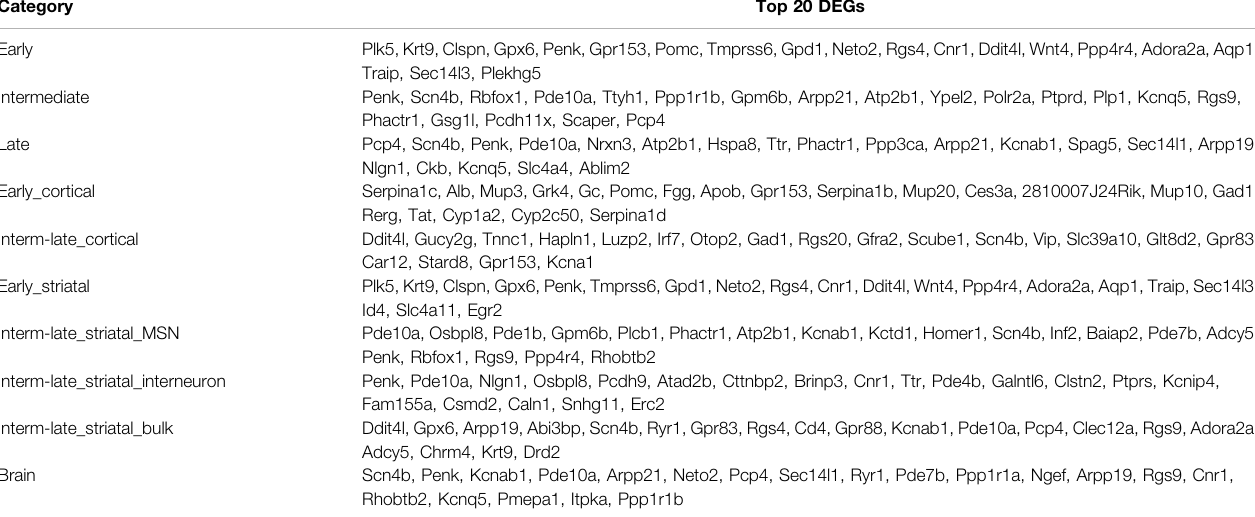
TABLE 6 | Mouse top differentially expressed genes (DEGs) in each category. The table summarizes the top DEGs in brain subcategories in mouse, fi rst ranked by the frequency of DEGs, then by the average FDR value of DEGs across all datasets in that subcategory.